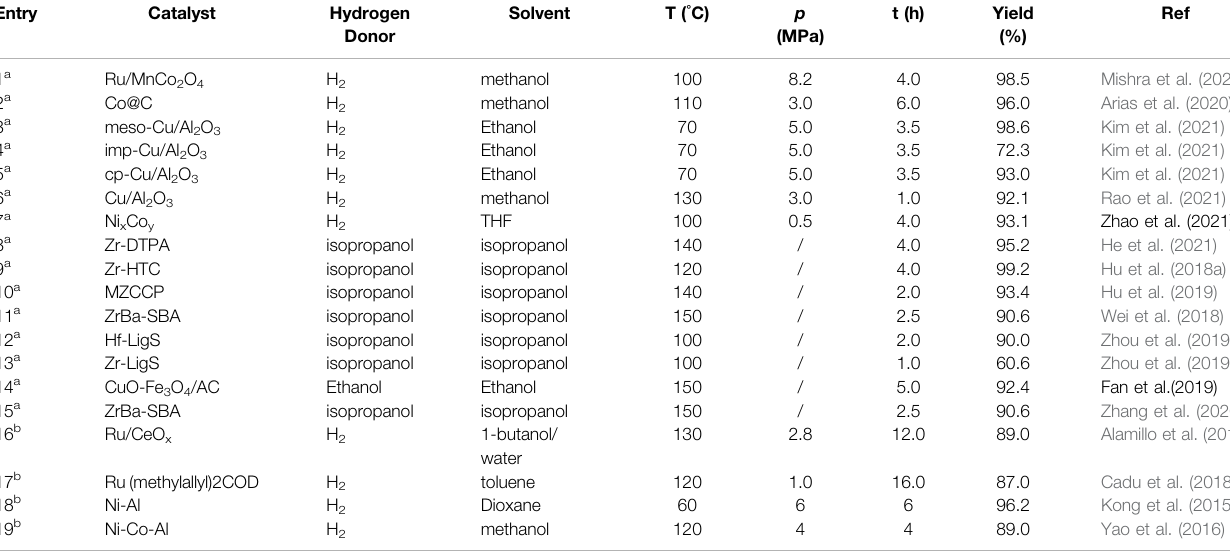
TABLE 1 | Catalytic performance of catalysts for the conversion of